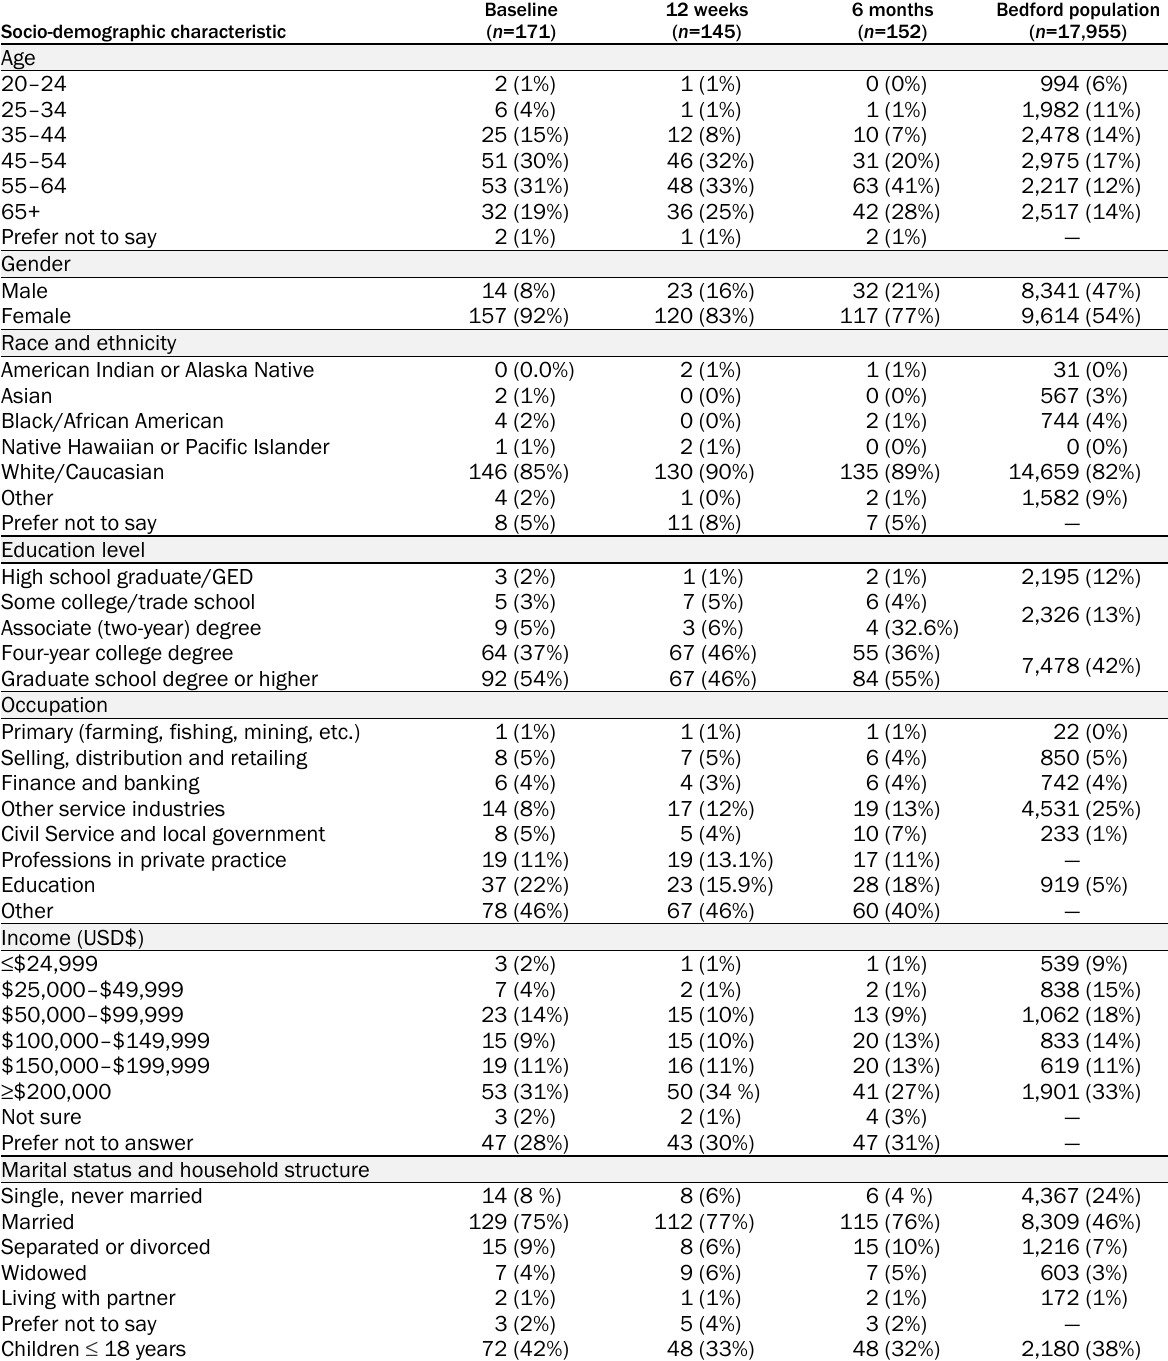
Table 2. Participant Socio-demographic Characteristics at Baseline, 12 Weeks, and Six-month Follow-up Socio-demographic